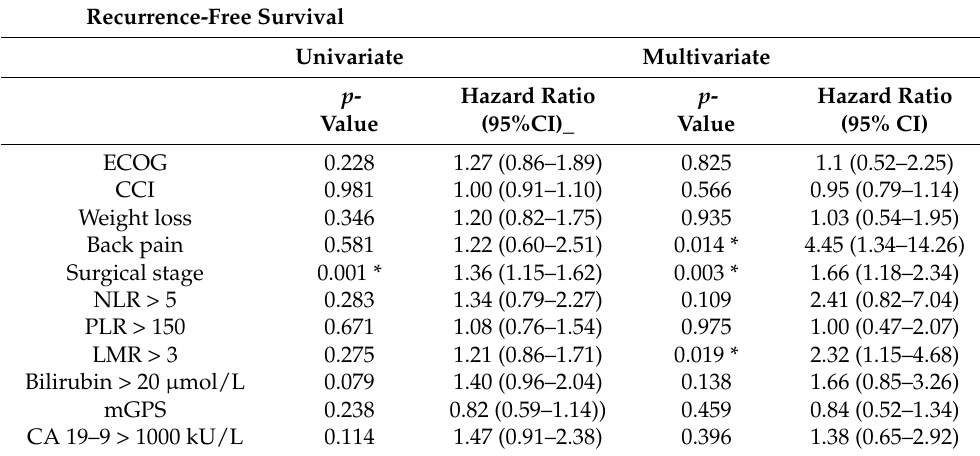
Table 3. Clinical and inflammatory prognostic markers of recurrence-free